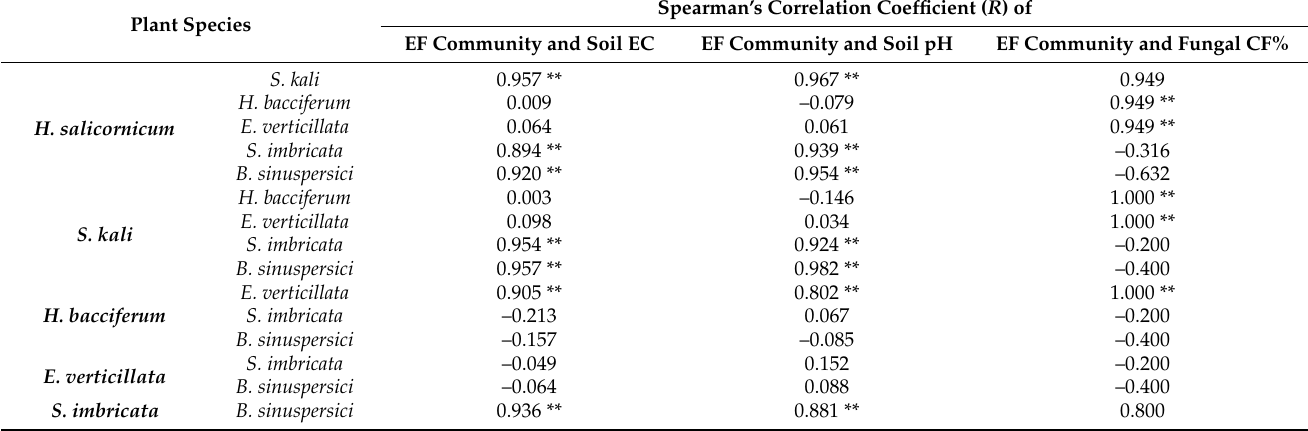
Table 4. Summarized table of Spearman correlations showing the correlated pairs of the EF com- munity of six plant hosts in relation to the soil electrical conductivity (EC), soil pH and fungal colonization frequency